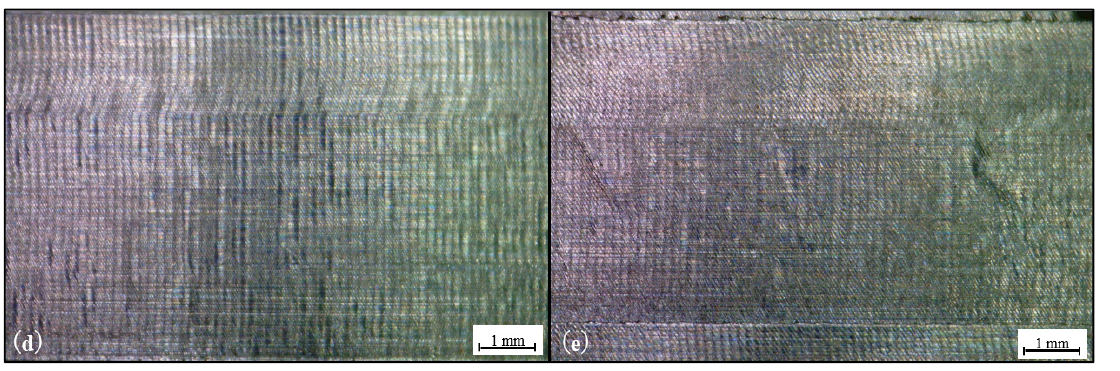
Figure 14. Machined Surfaces (Annealed sample) ( d )—0 degrees, ( e ) 35 degrees .